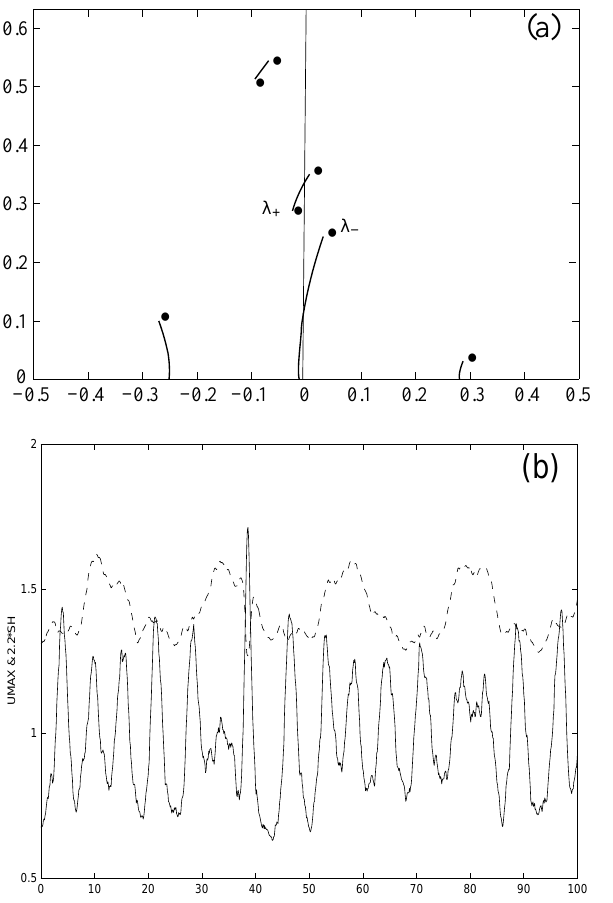
Fig. 16: (a) Spectrum and (b) evolution of U max “near” to homoclinic data.